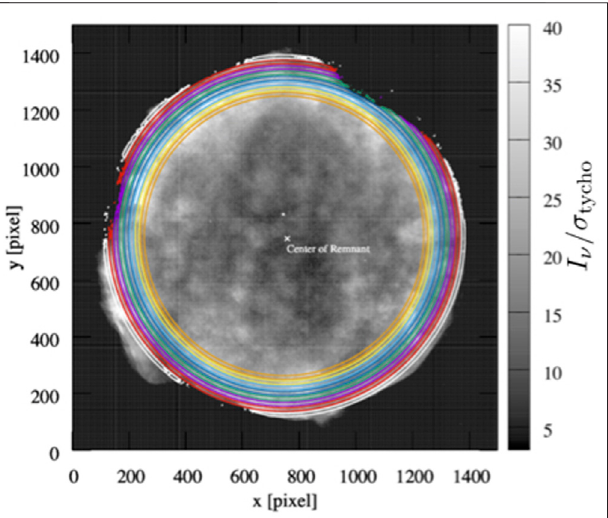
FIGURE 6 | Radio synchrotron intensity image of SN 1572. The image noiselevelis σ tycho =5.3×10 – 5 Jybeam − 1 . x and y areinunitsofthenumberof pixels (one pixcel size is 0.4 arcsec). The origin of the coordinates (J2000) is (R.A, Dec.)=(0 h 25 m 19 s .1, +64 ° 08 ′ 23.0 ″ ). The region enclosed by colored lines (white, red, purple, green, blue, light blue, yellow, and orange) indicate I ] ≥ 3 σ tycho at each concentric circle ( R = 1.00 R SNR , 0.97 R SNR , 0.94 R SNR , 0.91 R SNR , 0.88 R SNR , 0.85 R SNR , 0.82 R SNR , and 0.79 R SNR ), where R SNR = 632 pixcels ≈ 253 arcsec ≈ 5 pc is the radius of the SNR. The width of each circleisset tobe0.0091 R SNR .Reproduced formShimodaet al.(2018a, Monthly Notices of the Royal Astronomical Society,